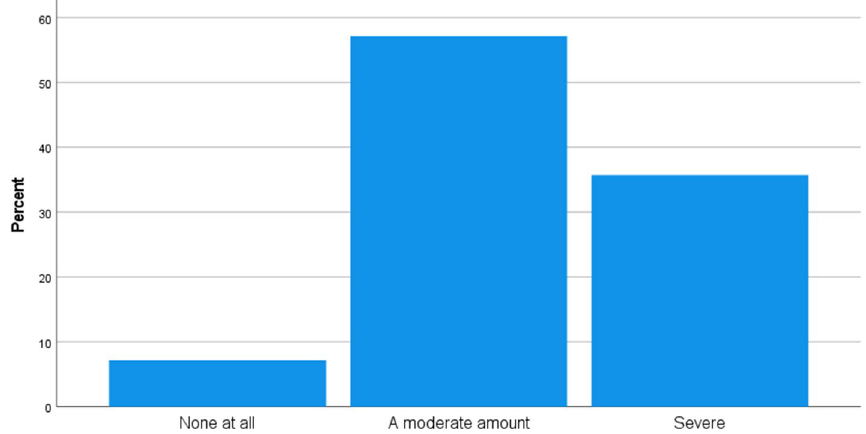
Fig. 5 How Brexit and Covid being of impact in your organisation?. Source